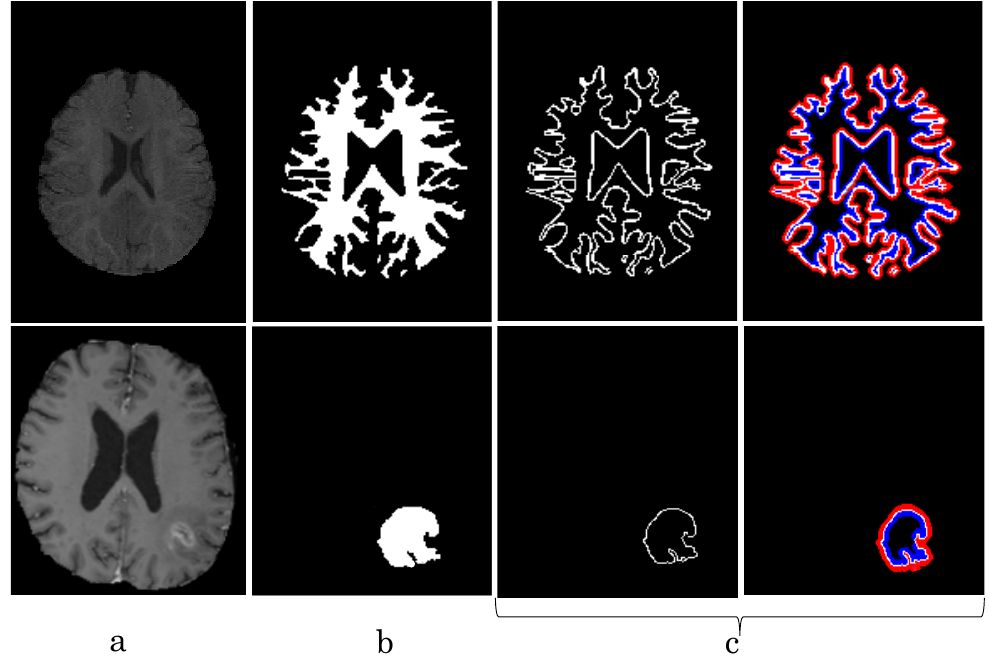
Figure 4. Given the raw data in ( a ), the proposed NB-AC loss contains both higher level feature loss ( b ) and lower level feature loss ( c ) including the length of the contour ( left ) and narrow band energy from both sides of the contour ( right